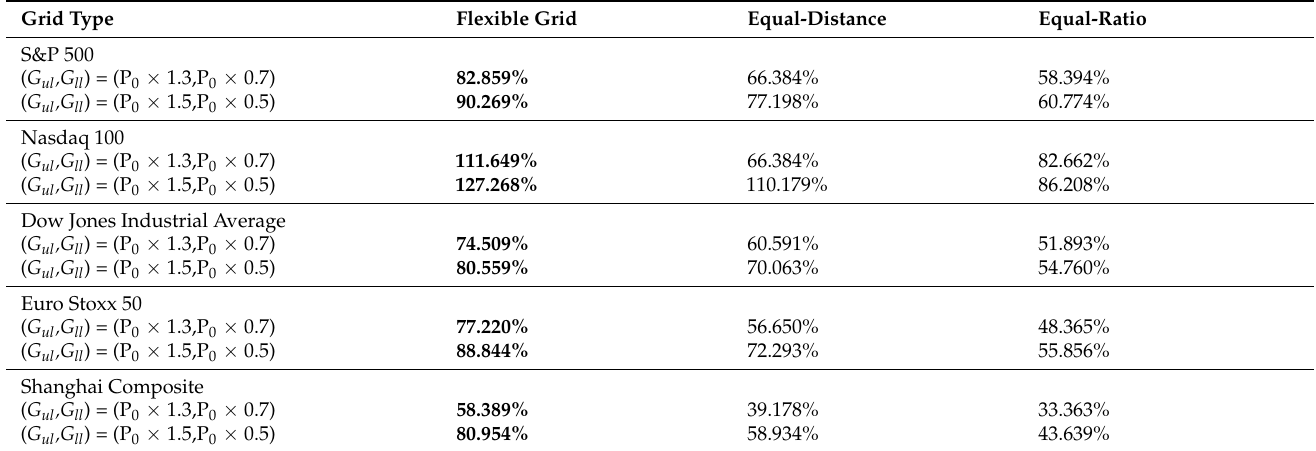
Table 9. ROI obtained by flexible grid, equal-distance grid, and equal-ratio grid with SSO parameters.